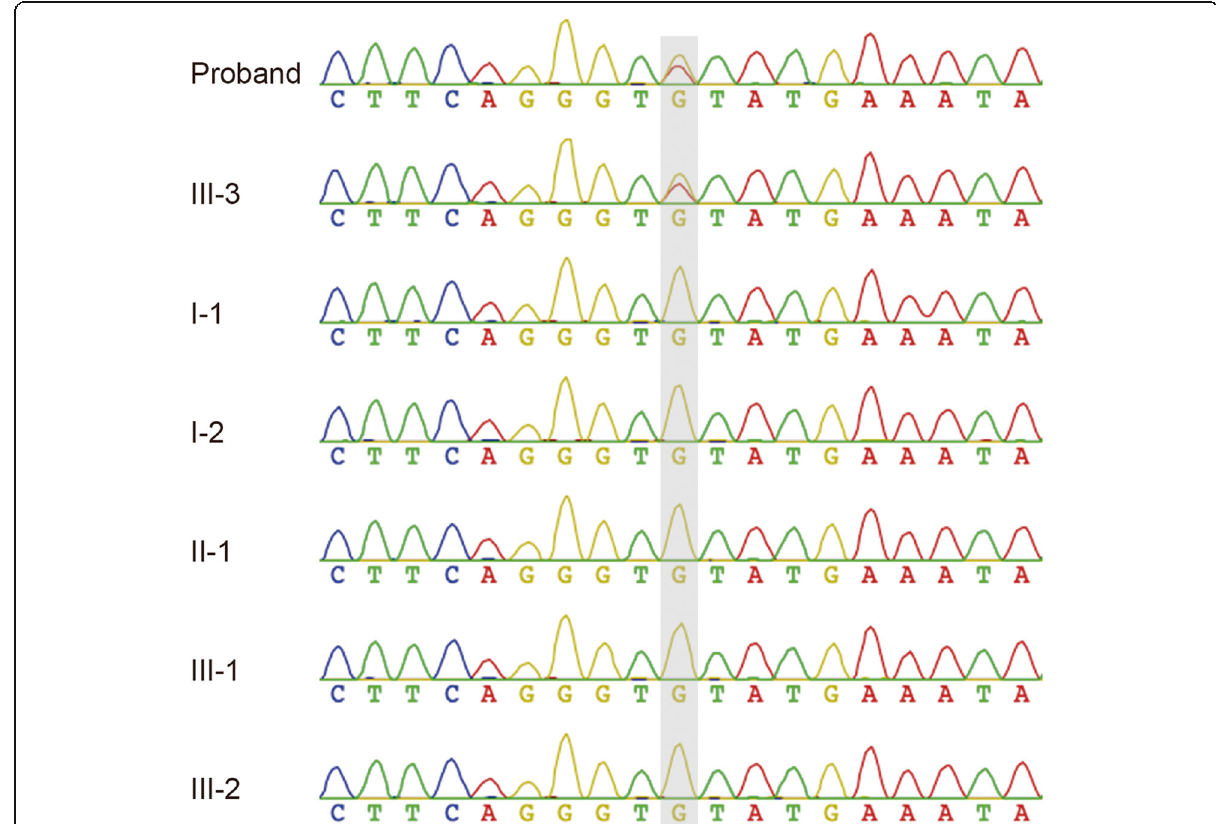
Fig. 2 Missense variant (c.299G > A) in the BMPR1A gene confirmed by sanger sequencing of the